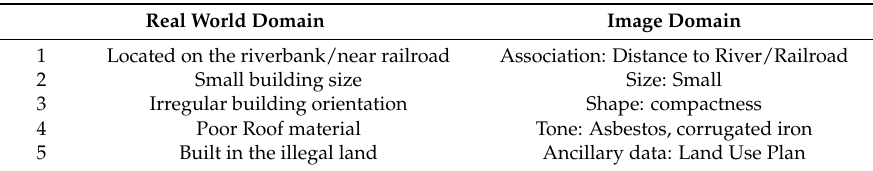
Table 2. Translation of the real world characteristics into image domain characteristics in the context of the Generic and the Local Ontology of Slums.